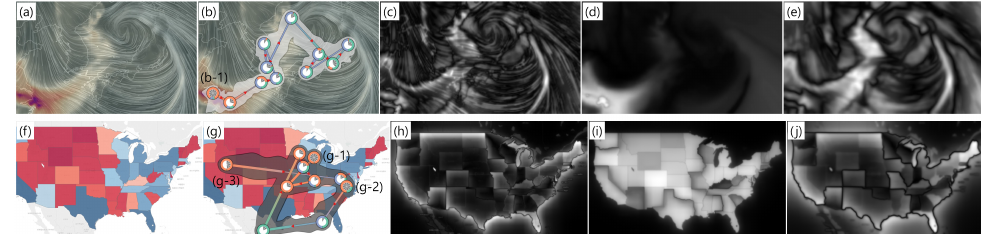
Figure 3. Gaze behavior analysis with the saliency features. ( a , f ) are the visual stimuli. ( b , g ) are the saliency-based gaze visualizations. ( c , h ) are the intensity feature map. ( d , i ) are the color feature map. ( e , j ) are the orientation feature